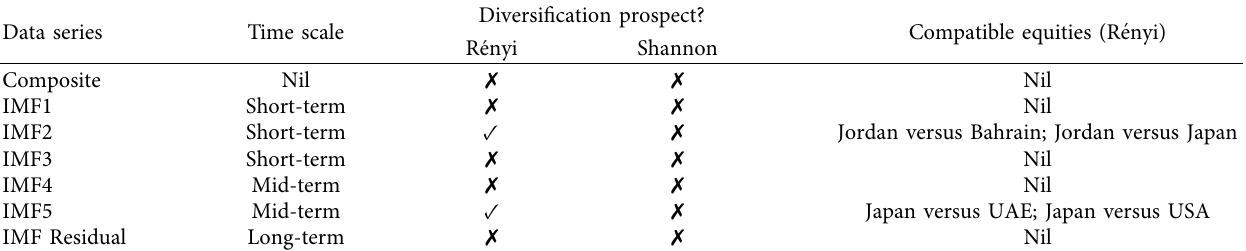
Table 2: Summary of diversification prospects from Islamic and conventional